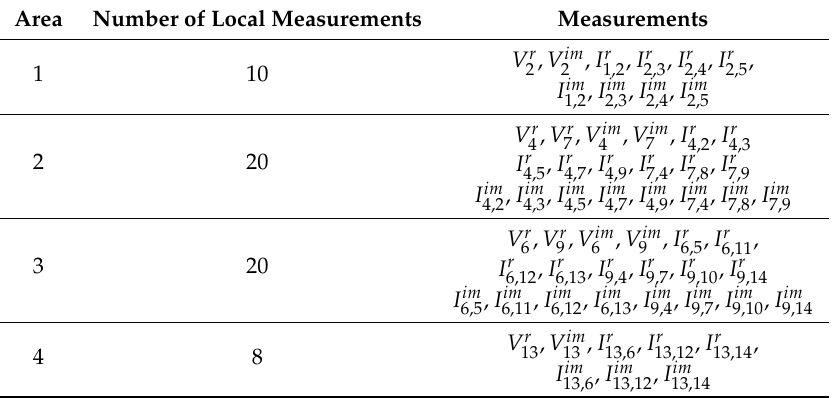
Table 1. Local measurements at time k allocated for each local area in the IEEE 14-bus system. Area Number of Local Measurements